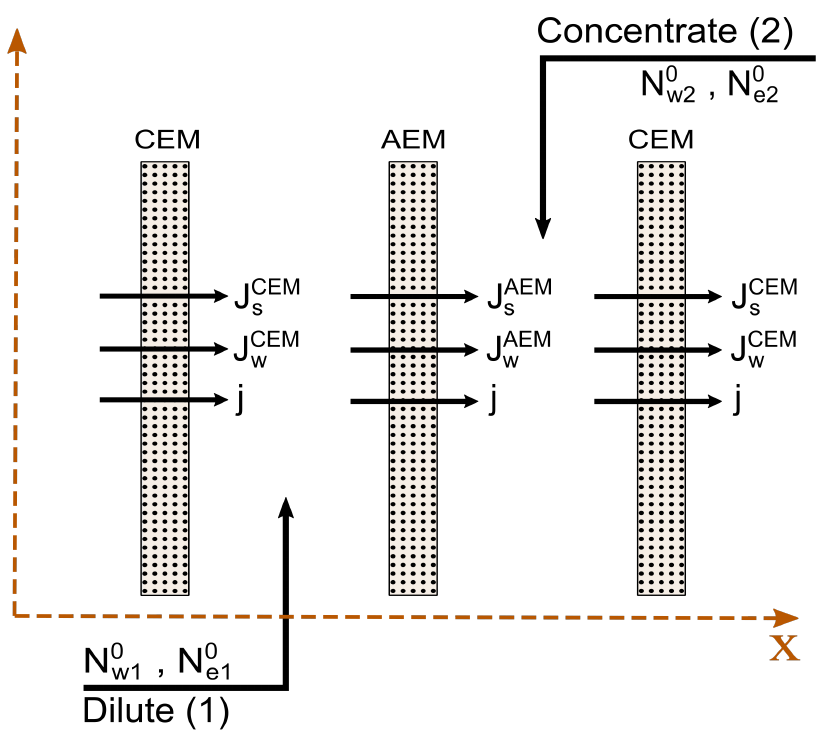
Figure 4. Sketch of the computational domain of the unit cell plus one additional CEM. Flux arrows show the positive direction, which may not correspond to the actual direction of